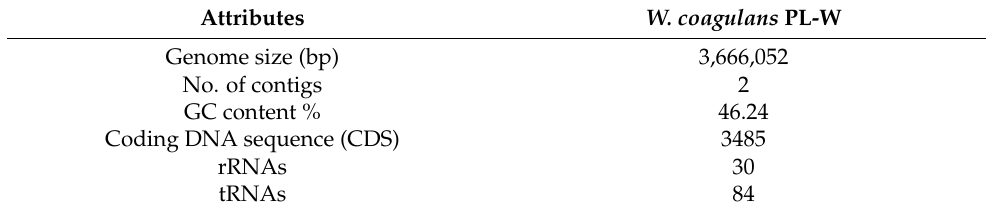
Table 2. General genome attributes of W. coagulans PL-W.